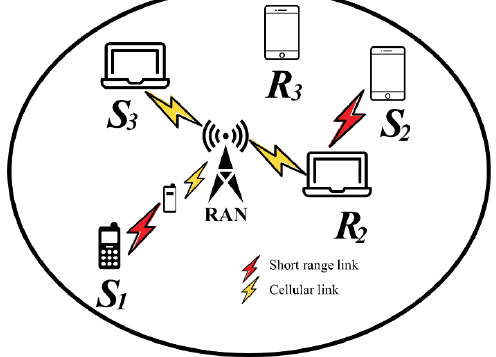
Figure 3. Coalitional short-range relaying.